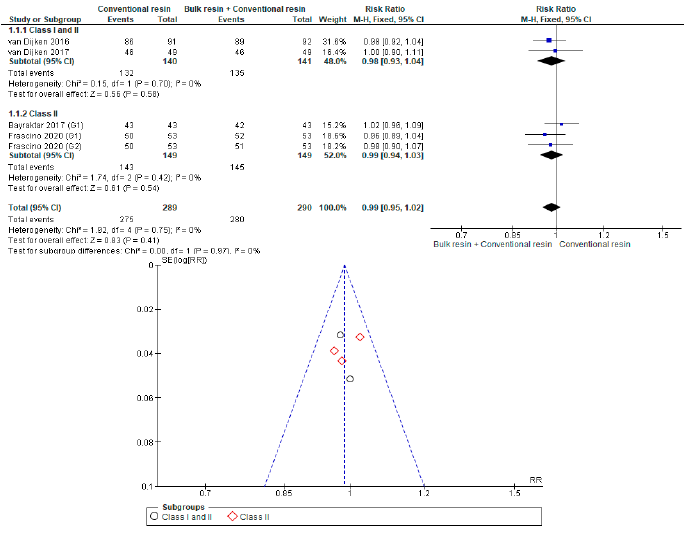
Figure A1. Absence of Fractures: Conventional Resin versus Bulk Resin Covered with Conventional Resin According to Type of Restoration.